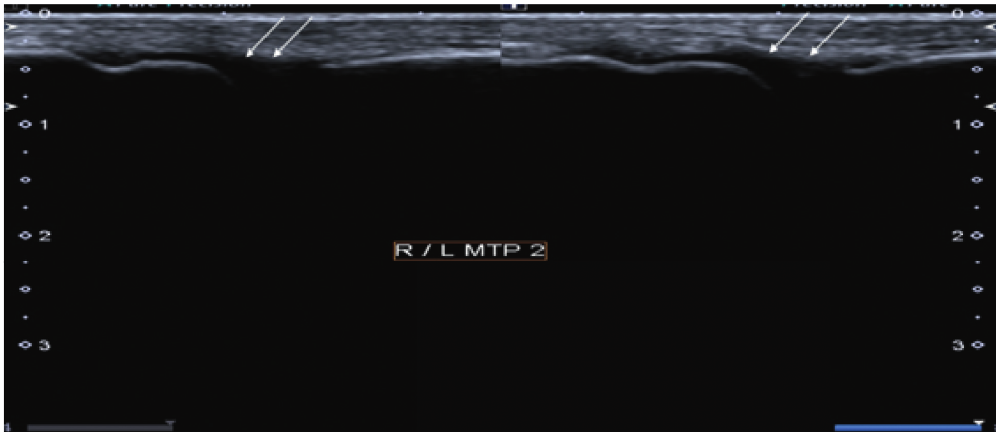
Figure 3: Grayscale images of bilateral 2 nd metatarsophalangeal joint demonstrating moderate synovial thickening (white arrows). The findings are consistent with Grade 2 synovitis.